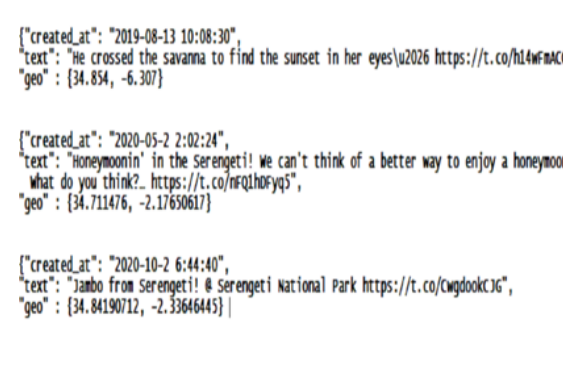
Figure 5. Examples of geotagged tweets.